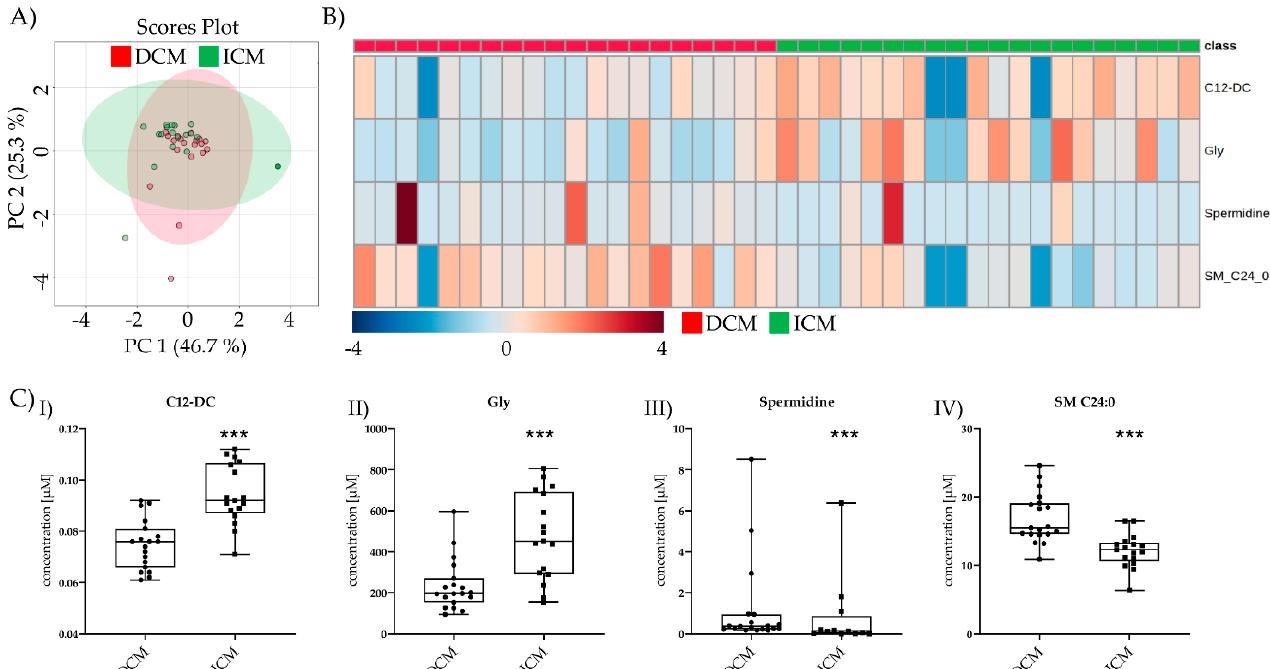
Figure 4. Comparison of significant metabolic parameters of DCM and ICM >100 days post-LVAD. ( A ) PCA of the significantly different metabolites >100 days post-LVAD DCM vs. >100 days post-LVAD ICM. ( B ) Heatmap visualization of the four metabolites significantly different between DCM and ICM >100 days post-LVAD. ( C ) I–IV C12-DC, Gly, spermidine, and SM C24:0 levels >100 days post-DCM vs. >100 days post-LVAD ICM. Depicted are min, max, median, and single values. Significance was calculated with a t -test) or the Mann–Whitney U test). * indicates significant to DCM (*** = p < 0.001).